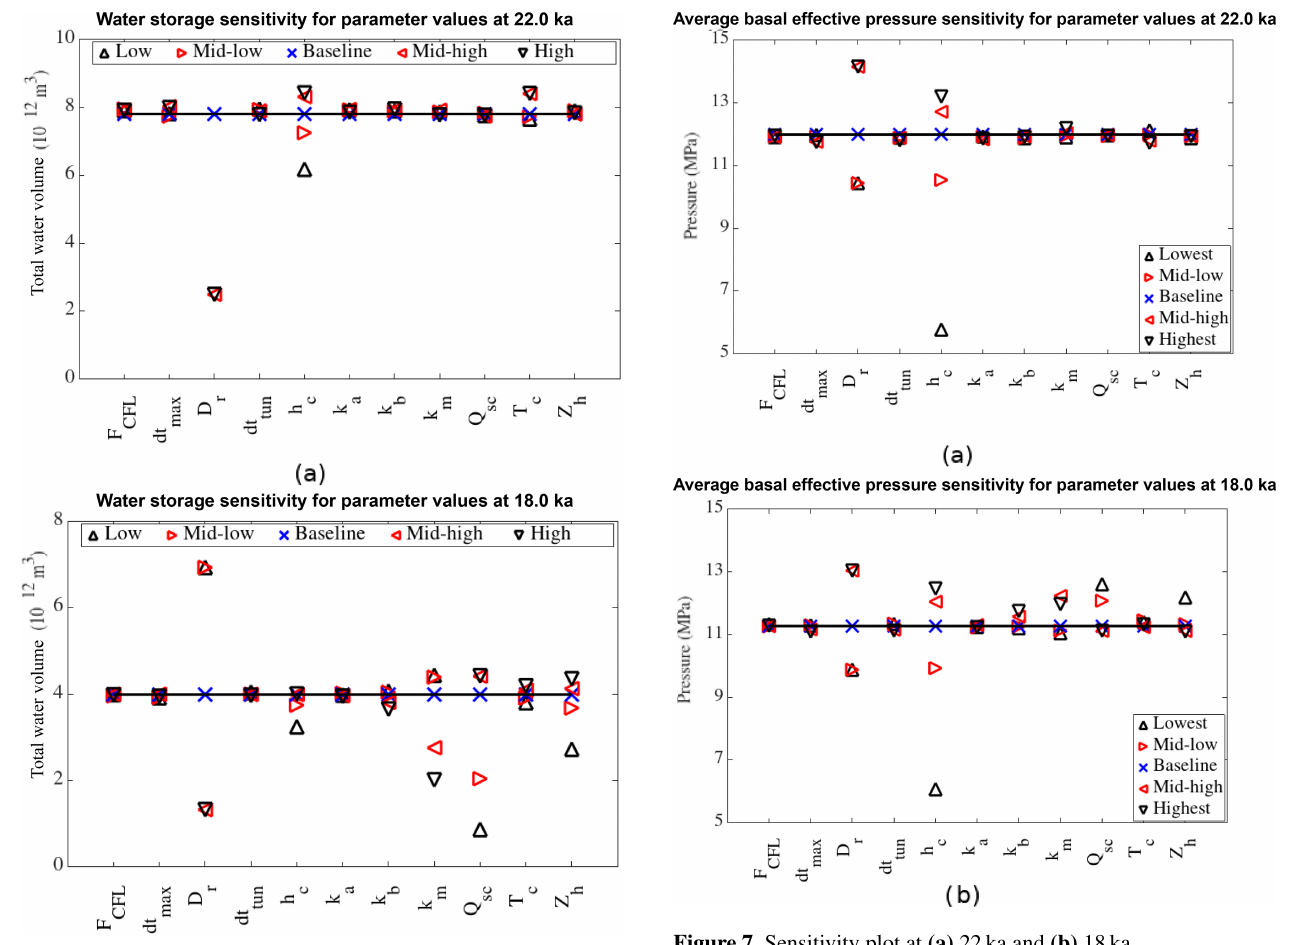
Figure 6. Sensitivity plot at (a) 22ka and (b) 18ka. Water storage for lowest D r value is off the scale (221 × 10 12 m 3 and 60 × 10 12 m 3 for 22 and 18ka, respectively).